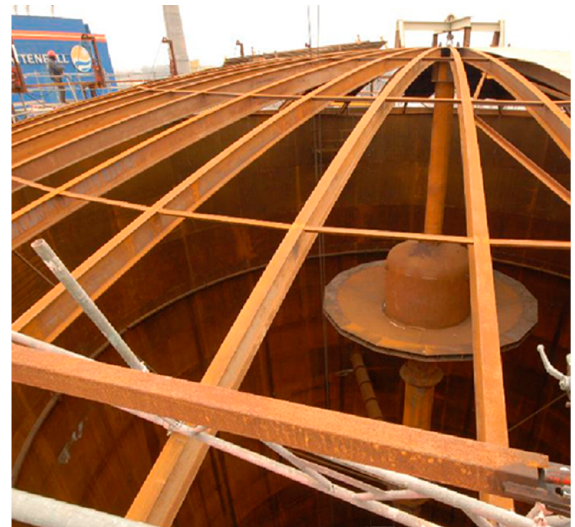
Figure 3. Upper orifice in the TES tank in CHP Siekierki–Warsaw [28].